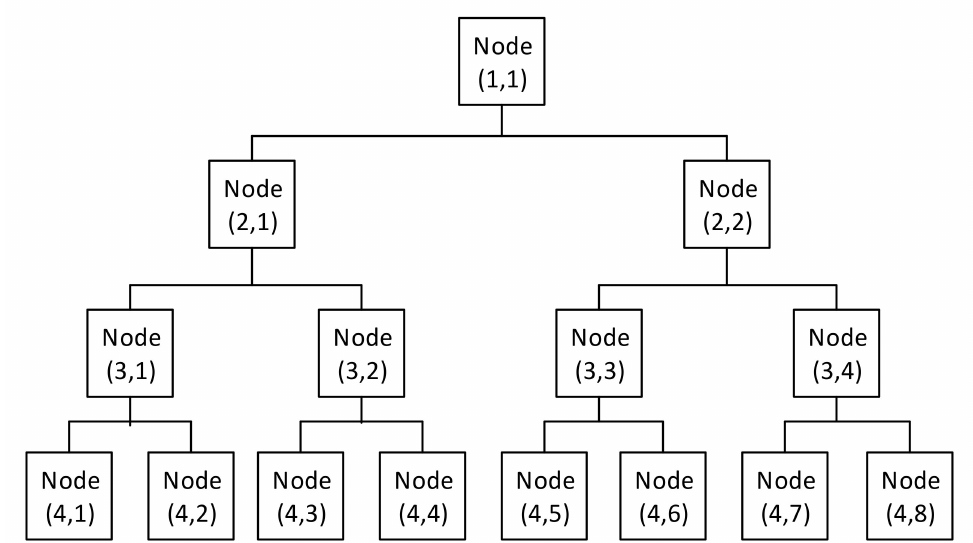
Figure 2. The binary tree of the organization and numbering of sub-bands in discrete wavelet packet transform